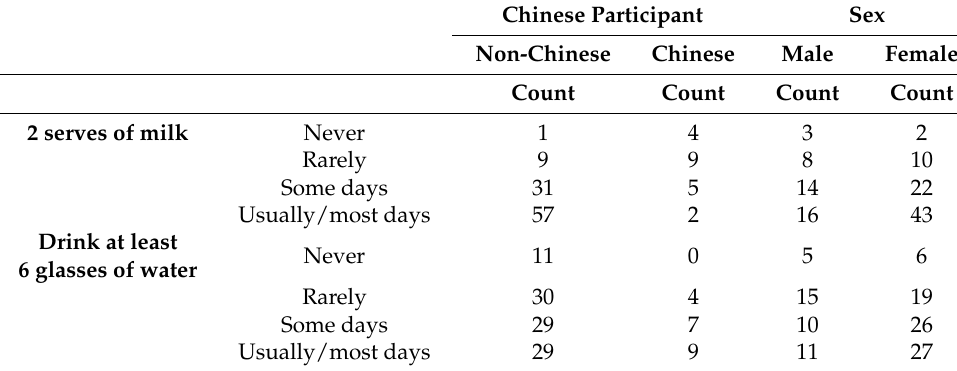
Table 4. Frequency of consumption (milk and water) by each person factor. Chinese Participant